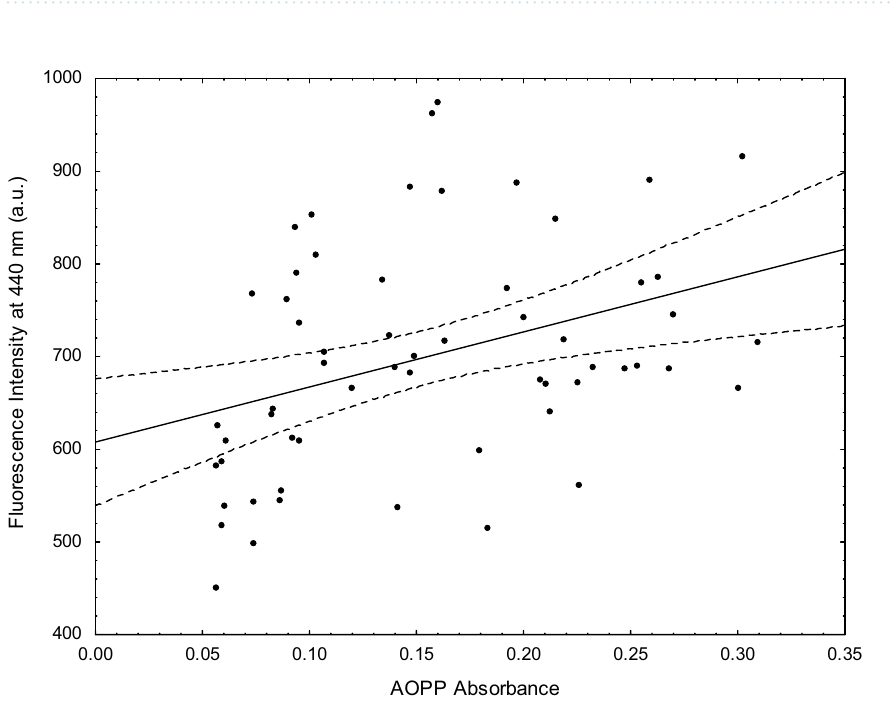
Figure 2. Dependence between fluorescence intensity at 440 nm and AOPP absorbance in healthy plasma donors. The dashed lines represent the 95% confidence intervals for the regression